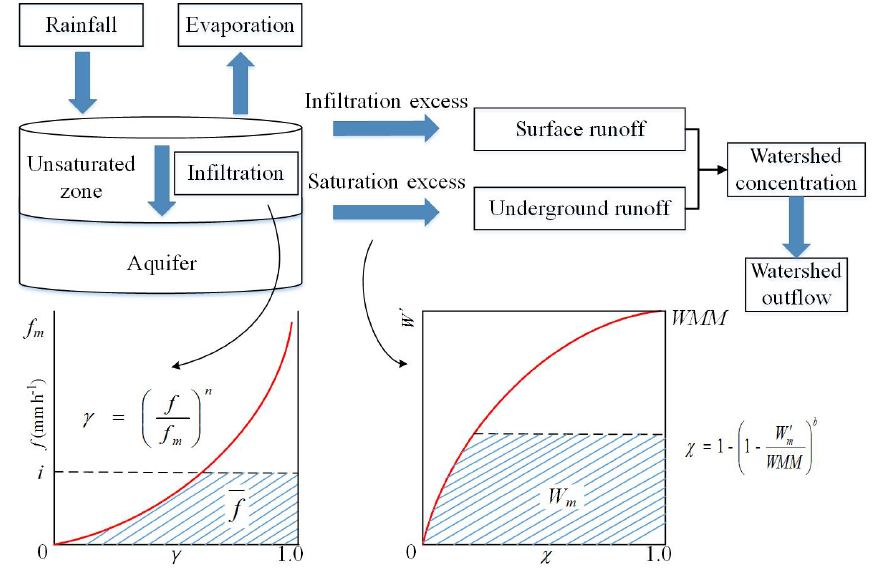
Figure 7. Main structure of the Hebei rainfall–runoff model built on each grid cell.